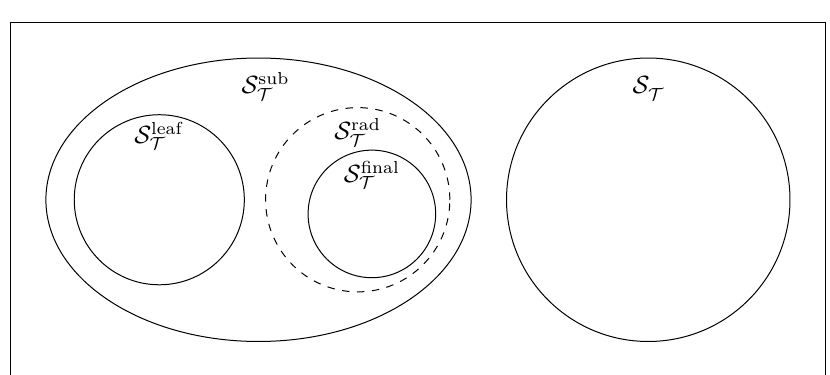
Figure 3: Venn diagram of the sets S leaf